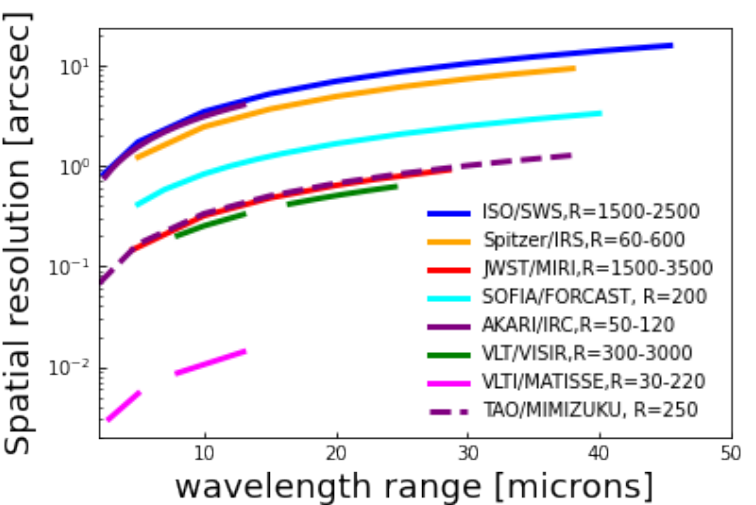
Figure 16. A summary of the wavelength coverage, resolving power, and spatial resolution of past, present and upcoming mid-IR